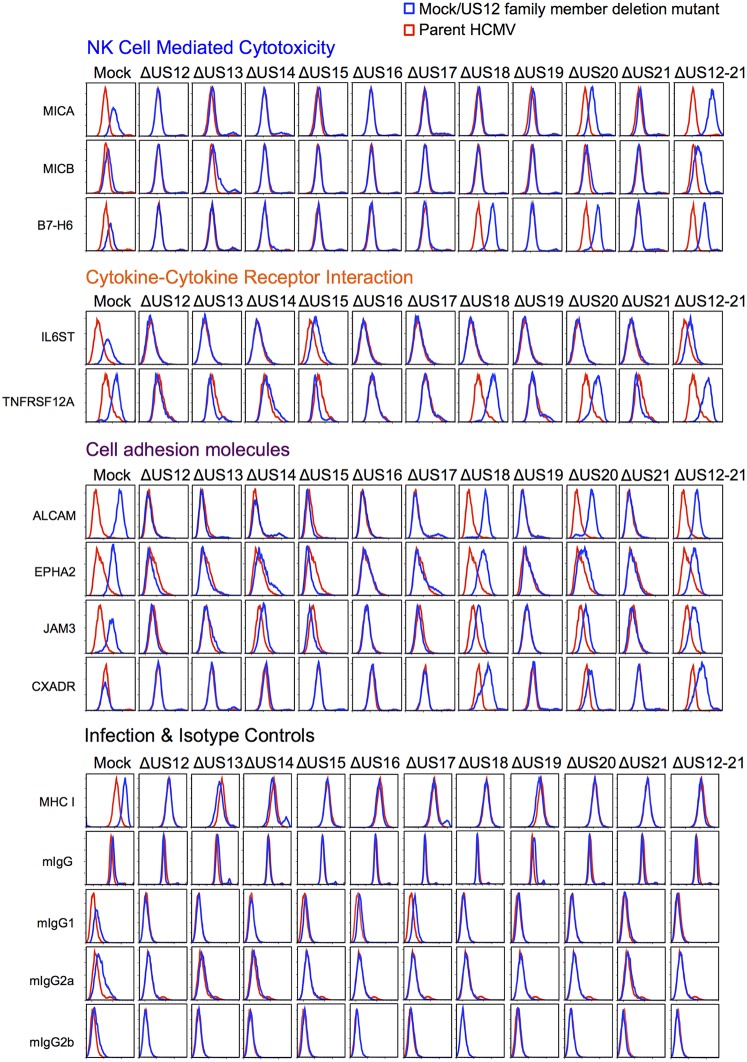
Validation of cell surface proteins regulated by the US12 family.Flow cytometry confirmed proteomic data for proteins representative of each category enriched in the DAVID analysis. Staining in mock/US12 family member deletion mutant infections (blue line) is shown relative to the parental HCMV infection (red line). Flow cytometry was carried out for cell surface expression of MHC I (W6/32) as a control for HCMC infection and isotype antibody staining controls (with directly PE-conjugated IgG1, IgG2a or IgG2b antibodies or for unconjugated antibodies mIgG and an anti-mouse-AF647 conjugated secondary antibody). Infected cells were assessed by the % cells with down-regulated MHC I compared to the mock-infected cells (HCMV 94%, ΔUS12 94%, ΔUS13 94%, ΔUS14 83%, ΔUS15 95%, ΔUS16 97%, ΔUS17 85%, ΔUS18 94%, ΔUS19 96%, ΔUS20 94%, ΔUS21 94%, ΔUS12-21 96%). Results are representative of at least two independent experiments.